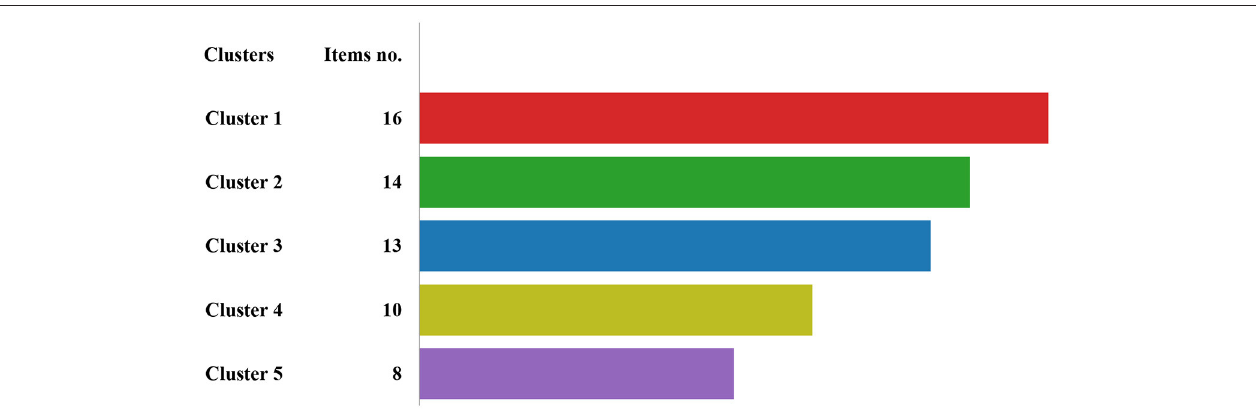
FIGURE 7 | Cluster analysis (Source: our elaboration).